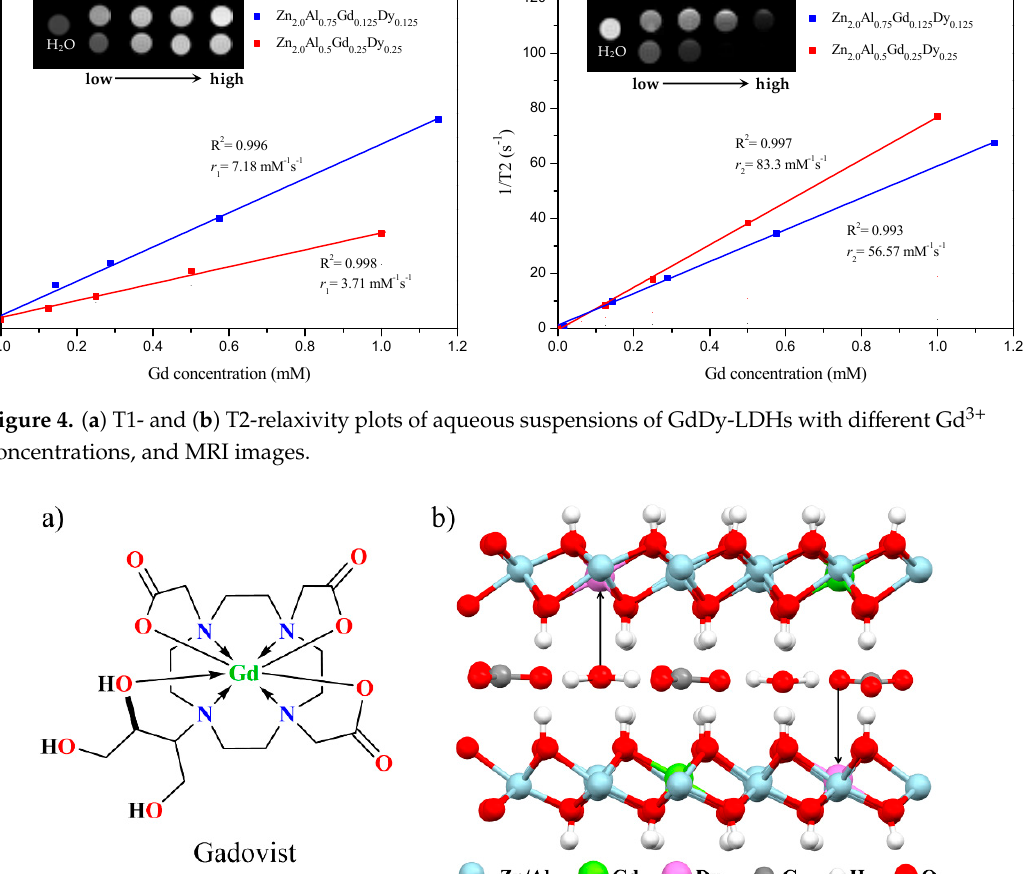
Figure 5. Schematic representation of ( a ) Gadovist and ( b ) GdDy-LDH.